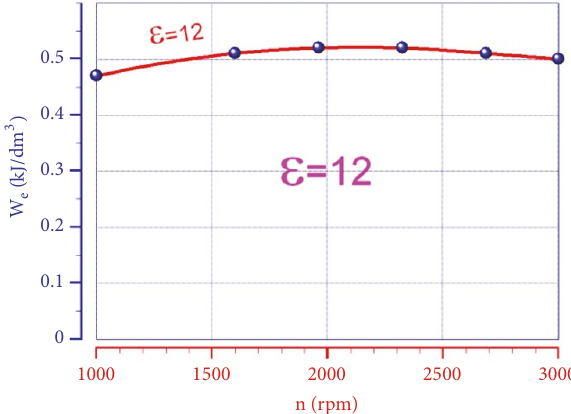
Figure 13: Selection of the optimal value of the (CR) for engine operating with the minimal PM emission. x